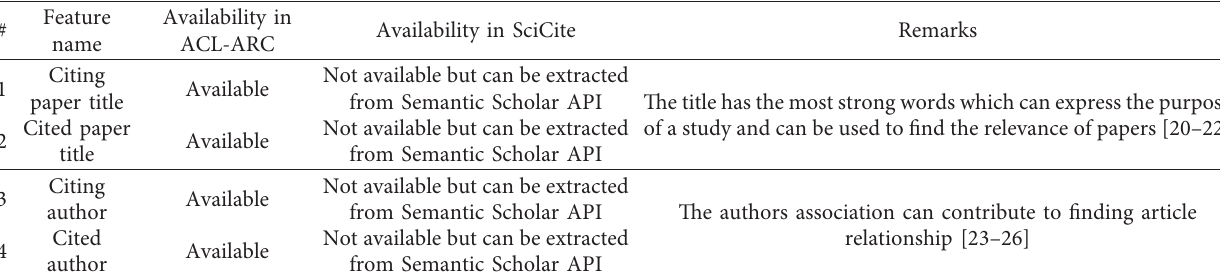
Table 3: The list of features selected for study and their availability in the selected